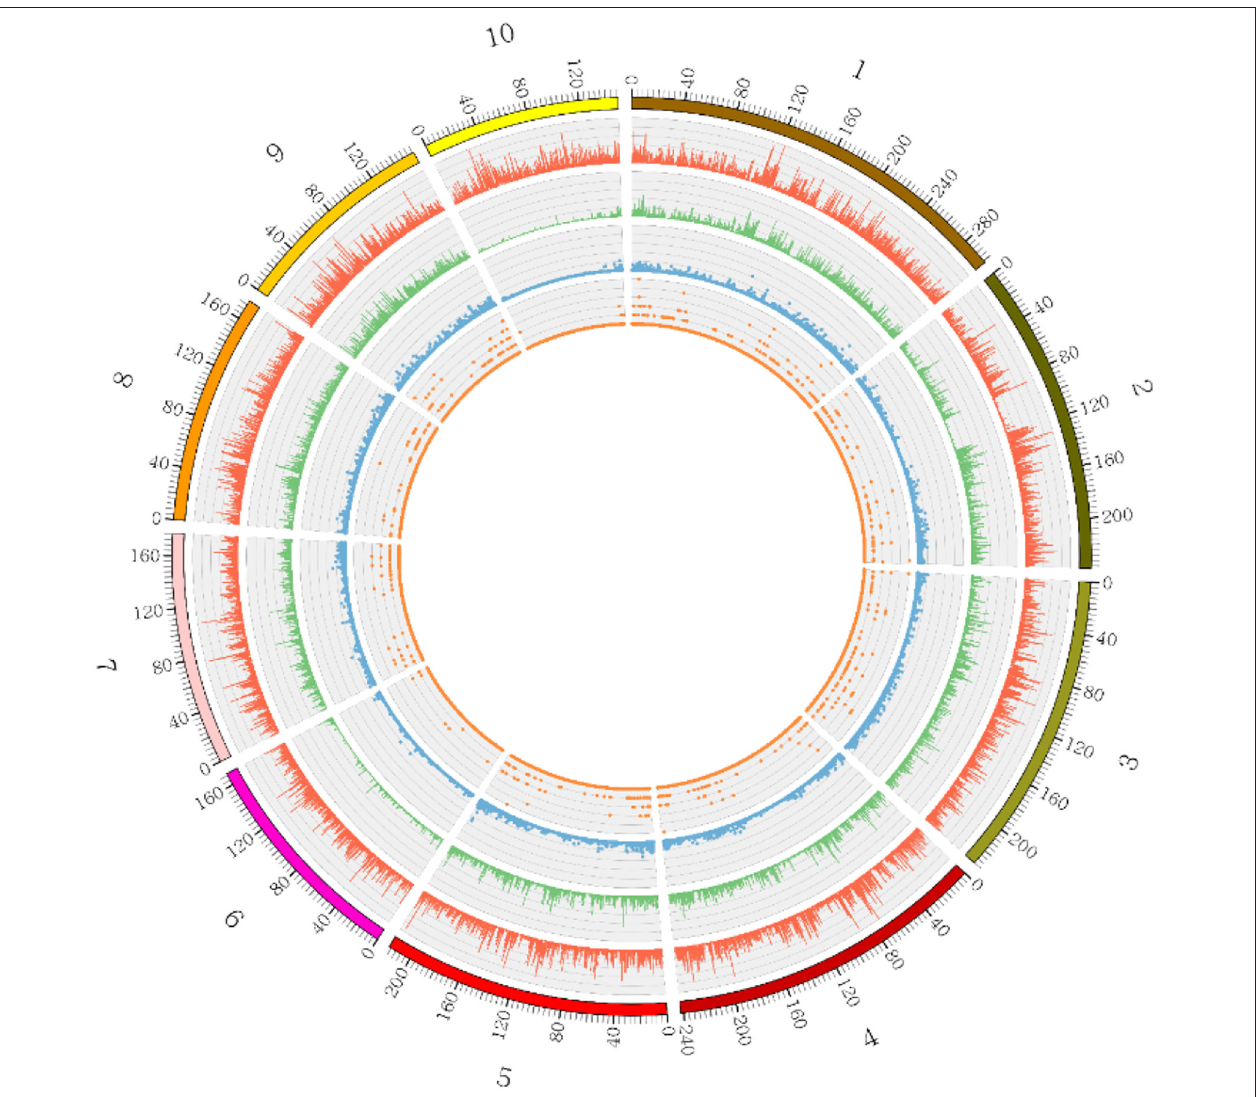
FIGURE 1 | Distribution and structural annotation of SNPs. Distributions of SNPs detected on each maize chromosome (5 kb window size) are shown in the Circos diagram. Track 1 represents the 10 maize chromosomes (1–10) in different colors. Tracks 2, 3, 4, and 5 represent raw SNPs, filtered SNPs, genes and exons, respectively. Different tracks are represented by different colors as